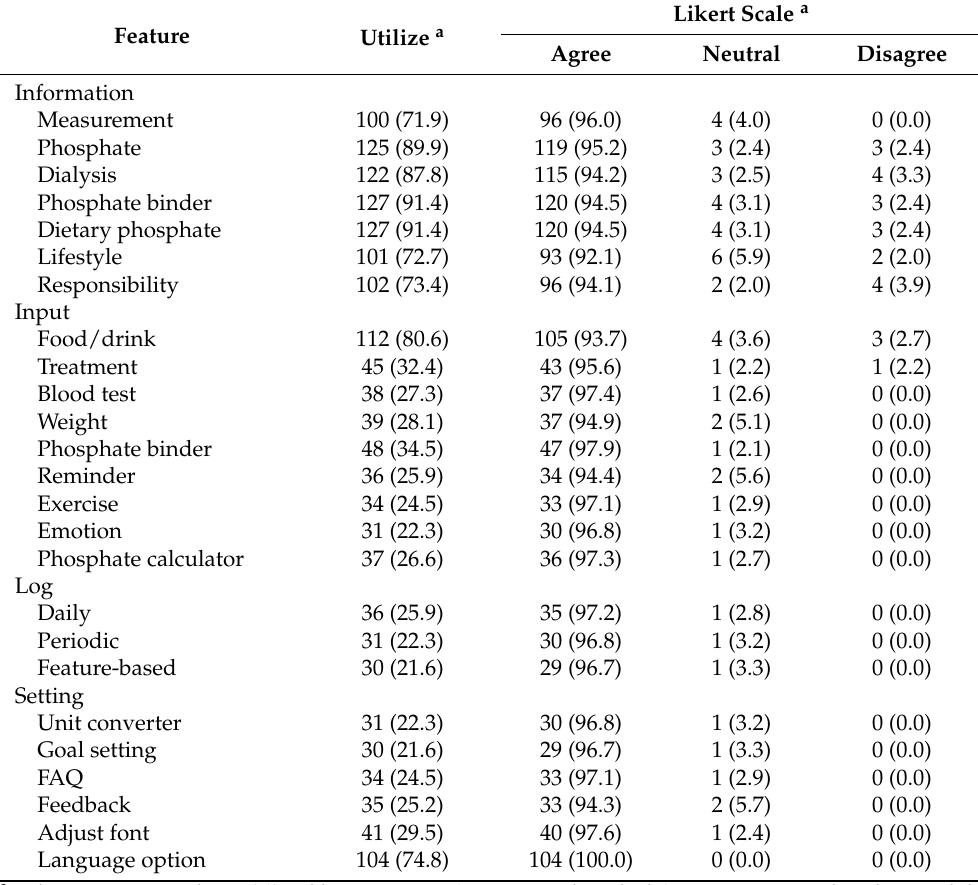
Table 3. Expectation confirmation of PMA